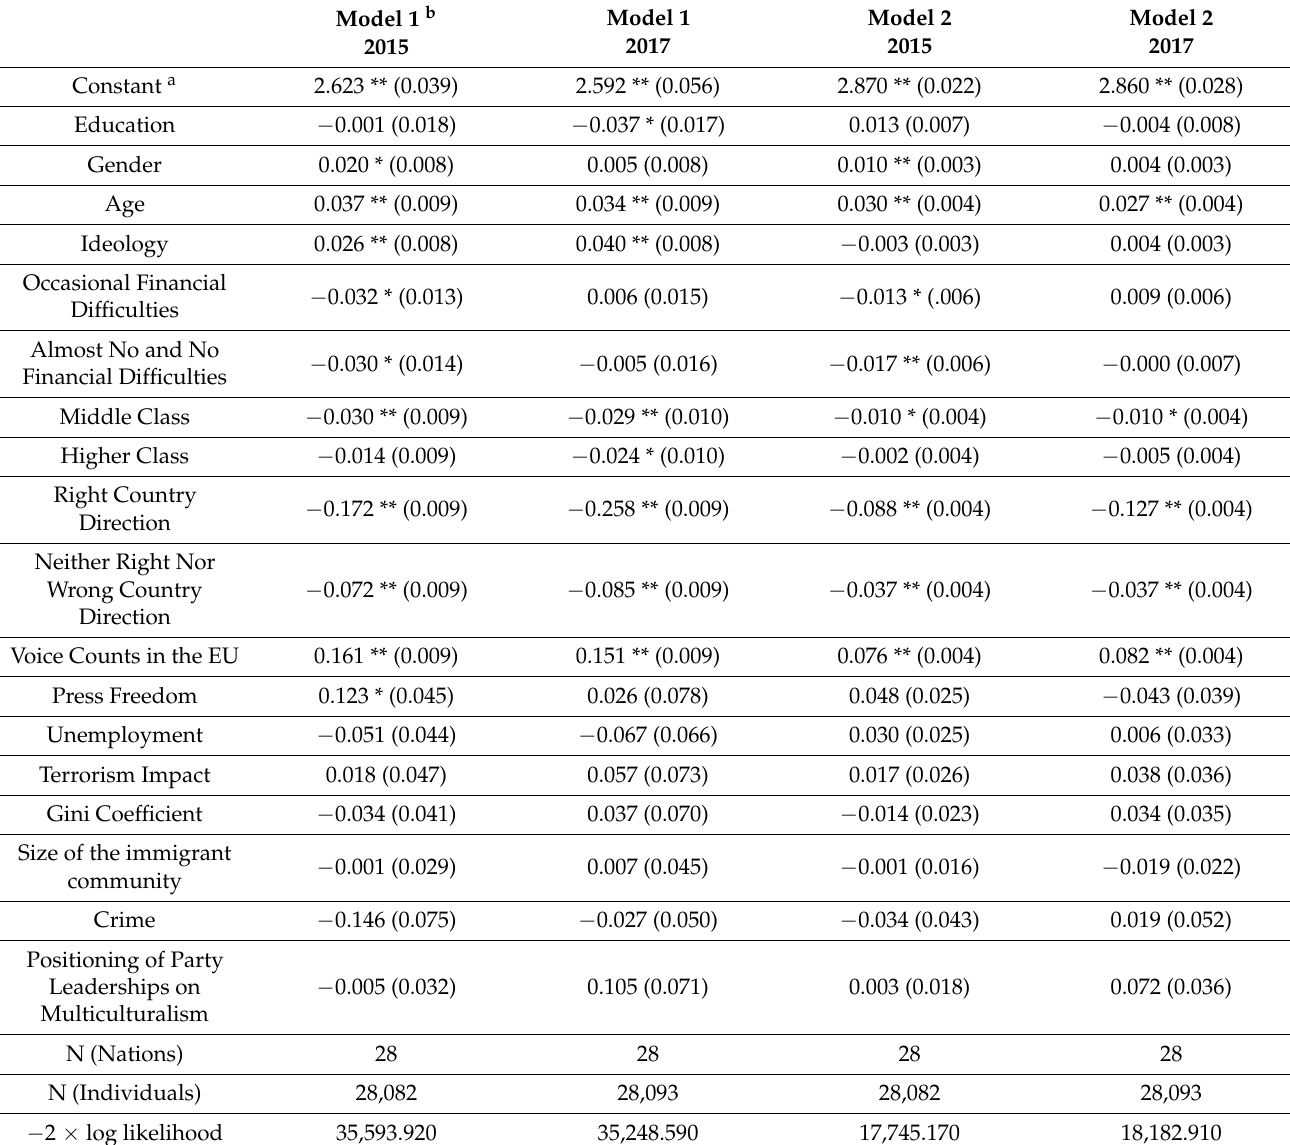
Table 4. Regression Estimates of Public Attitudes towards Terrorism